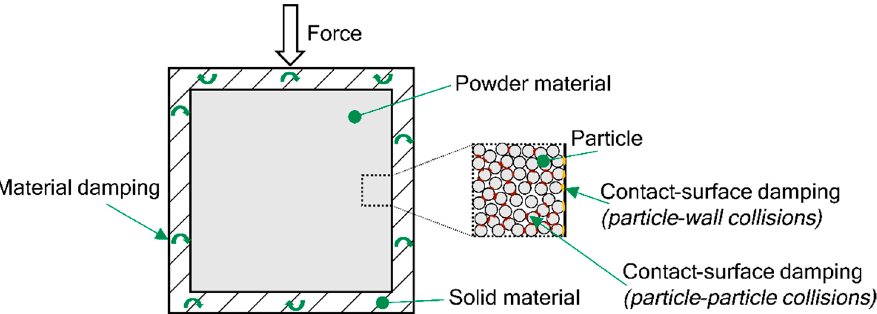
Figure 3. Damping mechanisms in a powder-based damping structure.